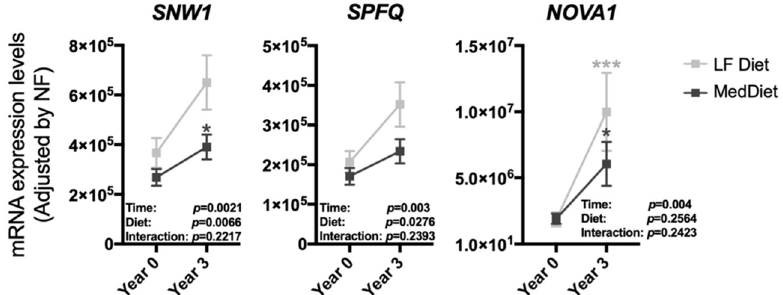
Figure 2. PBMCs expression pattern of the specific splicing machinery components after three years of follow-up under two healthy dietary patterns (low-fat (LF) diet and Mediterranean (Med) diet). mRNA expression levels [adjusted by a normalization factor (NF) calculated from the expression level of GAPDH and ACTB ] of specific spliceosome components and splicing factors in the PBMCs from all the participants included in the study. Values represent the mean ± SEM. Asterisks indicate values that significantly differ from non-T2DM subjects ( t -test: *, p < 0.05; ***, p < 0.001).